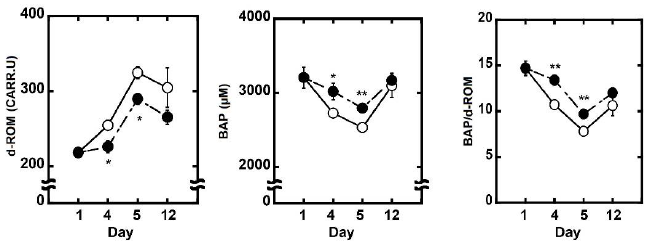
Figure 4. Evaluation of potential antioxidant capacity of rat plasma. Oxidative stress of plasma was evaluated by diacron-reactive oxygen metabolites (d-ROM) test. Antioxidant capacity was evaluated by the biological antioxidant potential (BAP) test. BAP/d-ROM showed potential antioxidant capacity. ( A ) The level of d-ROM; ( B ) The level of BAP; ( C ) The level of the BAP/d-ROM. NL ( ○ ) indicates negative control, light exposure, administration of solvent; and PF (●) indicates light exposure, administration of PF 300 mg/kg of body weight. Data represent the mean ± SEM ( n = 6). An asterisk indicates a significant difference between negative control and PF (* p < 0.05, ** p < 0.01) followed by Dunnett’s test.